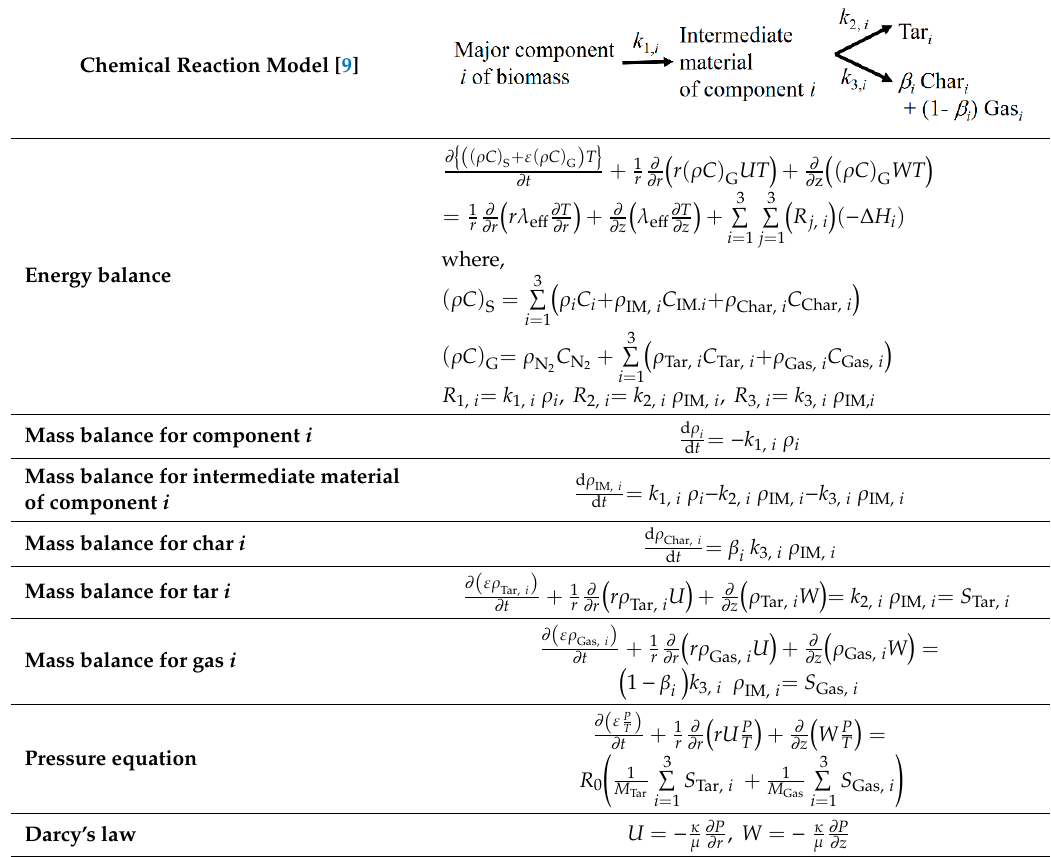
Table 4. Chemical reaction model and governing equations of the numerical simulation during the biomass torrefaction.